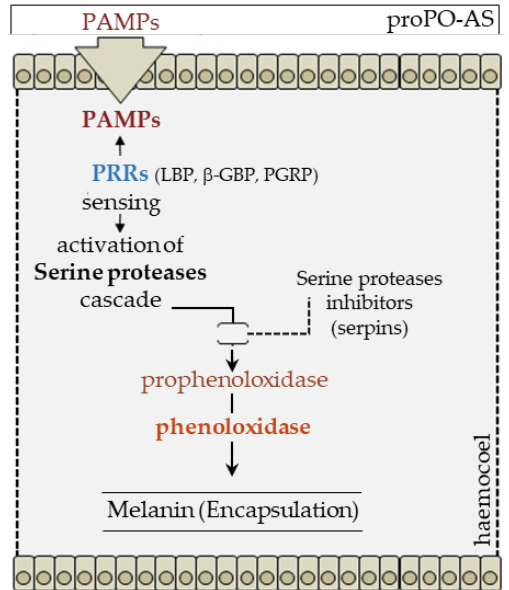
Figure 7. Insect proPO activating system is strongly elicited by the presence of PAMPs, prophenoloxidase zymogen, after PRRs-PAMPs interaction, is activated by serine proteases cascades; physiological negative control (serpins) provide the downregulation of the enzyme activity to turn-off the system when not required. The system is responsible of humoral melanization (melanin encapsulation) of foreign targets.